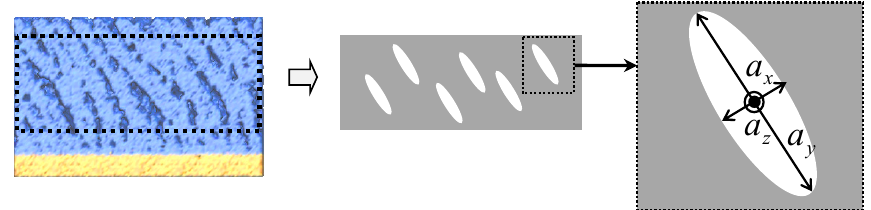
Figure 2. Representation of the porous structure in the framework of the anisotropic Bruggeman effective medium approach. The shape parameters of the ellipsoids a x , a y and a z are calculated by averaging the pores’ dimensions along coordinate system axes.